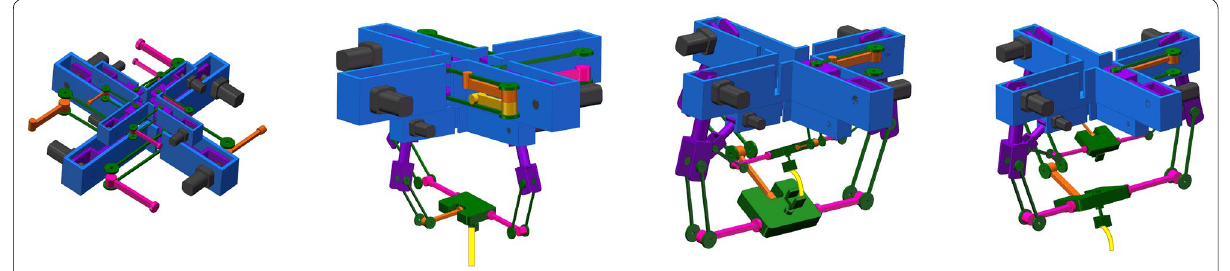
Figure 17 Working modes of Type‑II mechanism